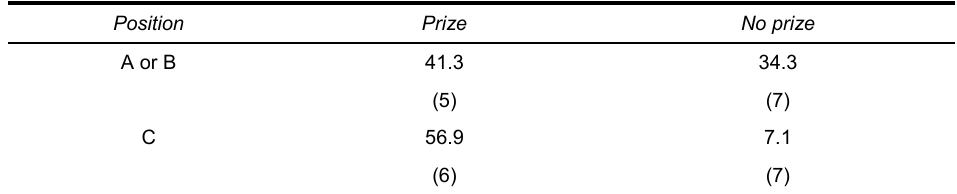
Table 6: Mean contribution levels over treatments in non-cooperative parts of the game, contingent on position